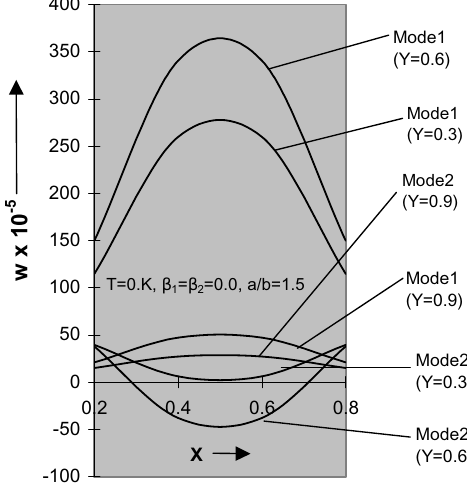
Fig. 4. Deflection w vs X of a clamped visco-elastic rectangular